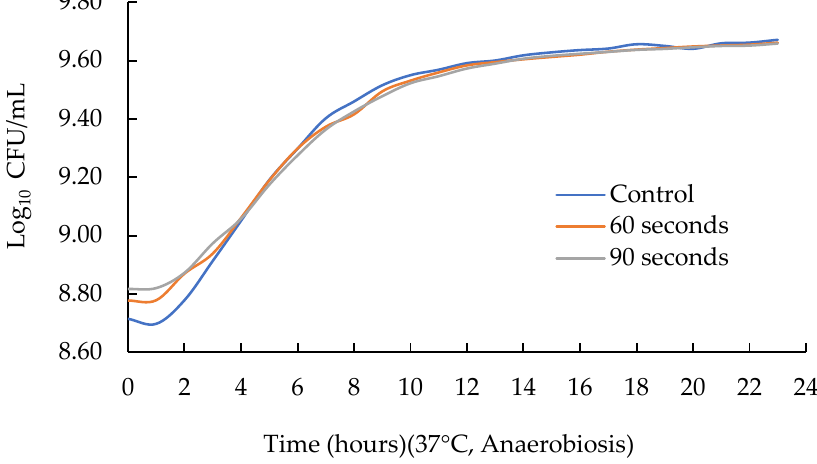
Figure 3. Effect of sonication time on the growth curve of Lactobacillus acidophilus .